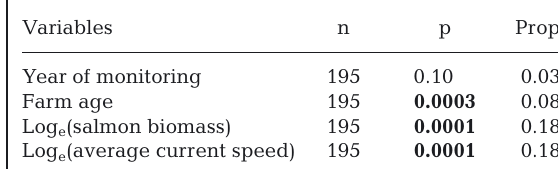
Table 3. Probabilities (p) and proportions (prop.) of variation explained, in marginal tests of individual variables as pre- dictors of the average sediment sulfide concentration (log e transformed) in annual monitoring at salmon farms, 2006 to 2009. Tests were performed using the DistLM (distance- based linear models) routine within PERMANOVA+ for PRIMER 6 software. Values in bold were significant (p <